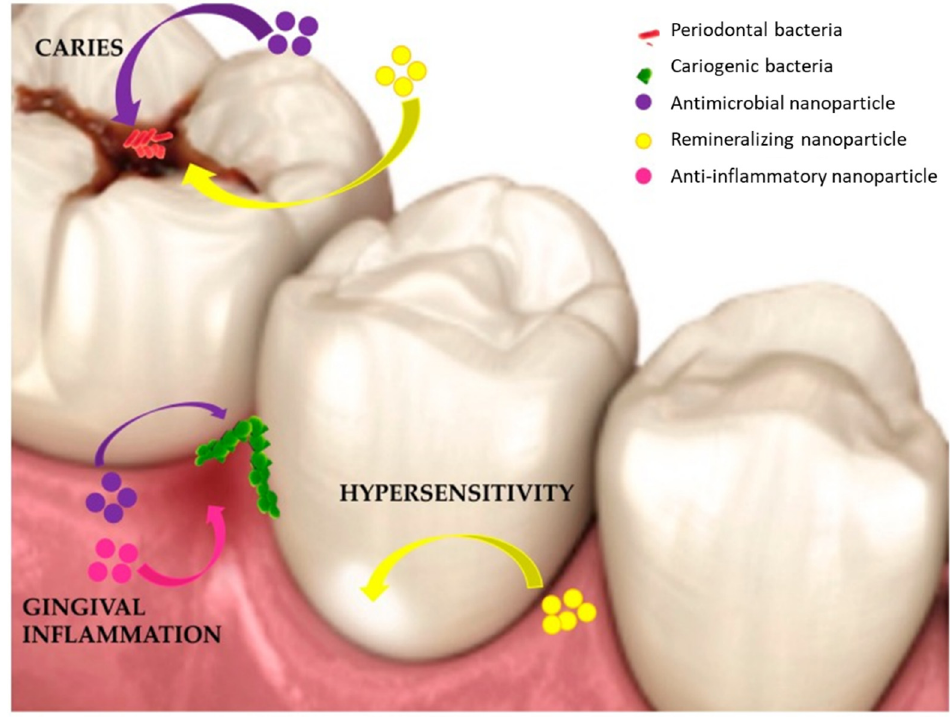
Figure 2. Application of nanoparticles (NPs) contained in oral care products. Reprinted with permission from Ref. [90], 2020, MDPI.